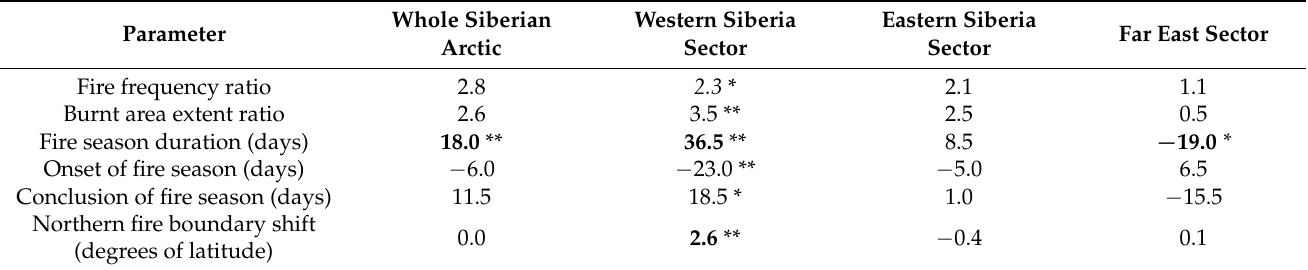
Figure 2. For the Siberian Arctic as whole, ( a ) decadal mean fire frequency and burned area (broken lines) increased 2.8 and 2.6 times from 2001–2010 to 2011–2021. ( b ) The mean timing of the wildfire season has a unimodal pattern, whereas the 2019 extreme fire year is bimodal, atypical of the Siberian Arctic. ( c ) Duration of the wildfire season differs across the Arctic, with an increase for Western Siberia and decrease for the Far East sector. Trends significant at p < 0.05. Table 1. Wildfire parameters for the Siberian Arctic and its regional sectors: a median values comparison of two time intervals (2001–2010 vs.